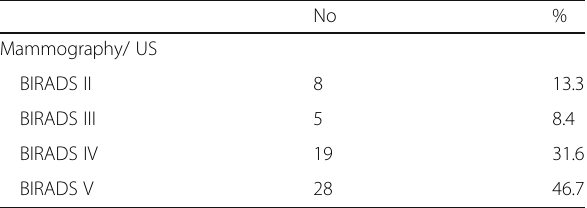
Table 2 Distribution of the studies patients BIRAD